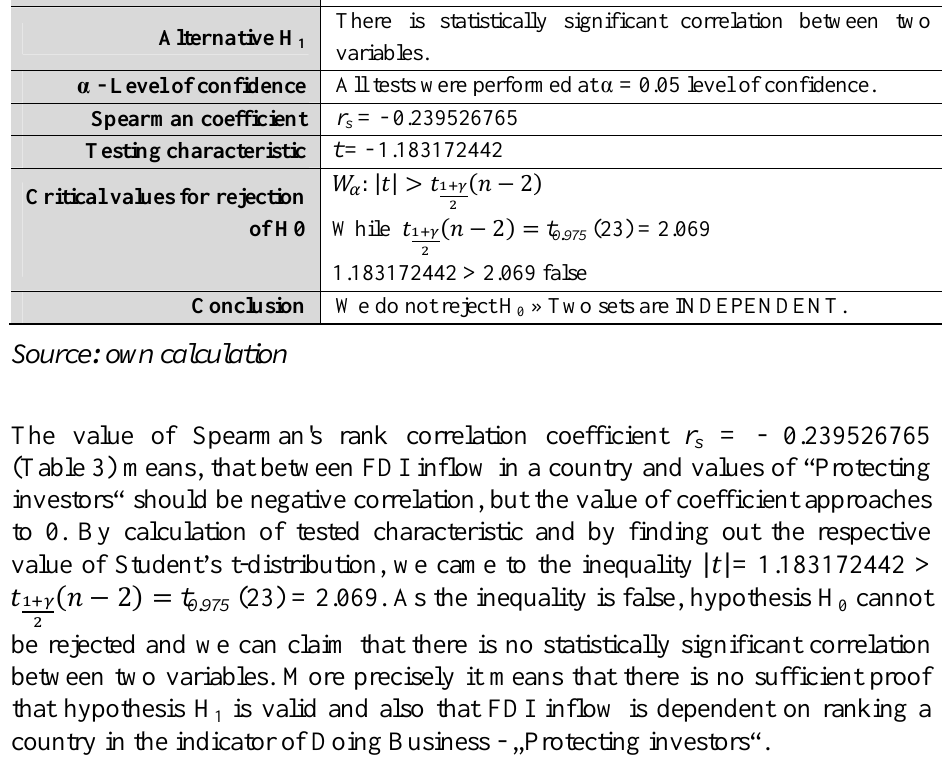
= 1.183172442 > |(cid:27)| 0